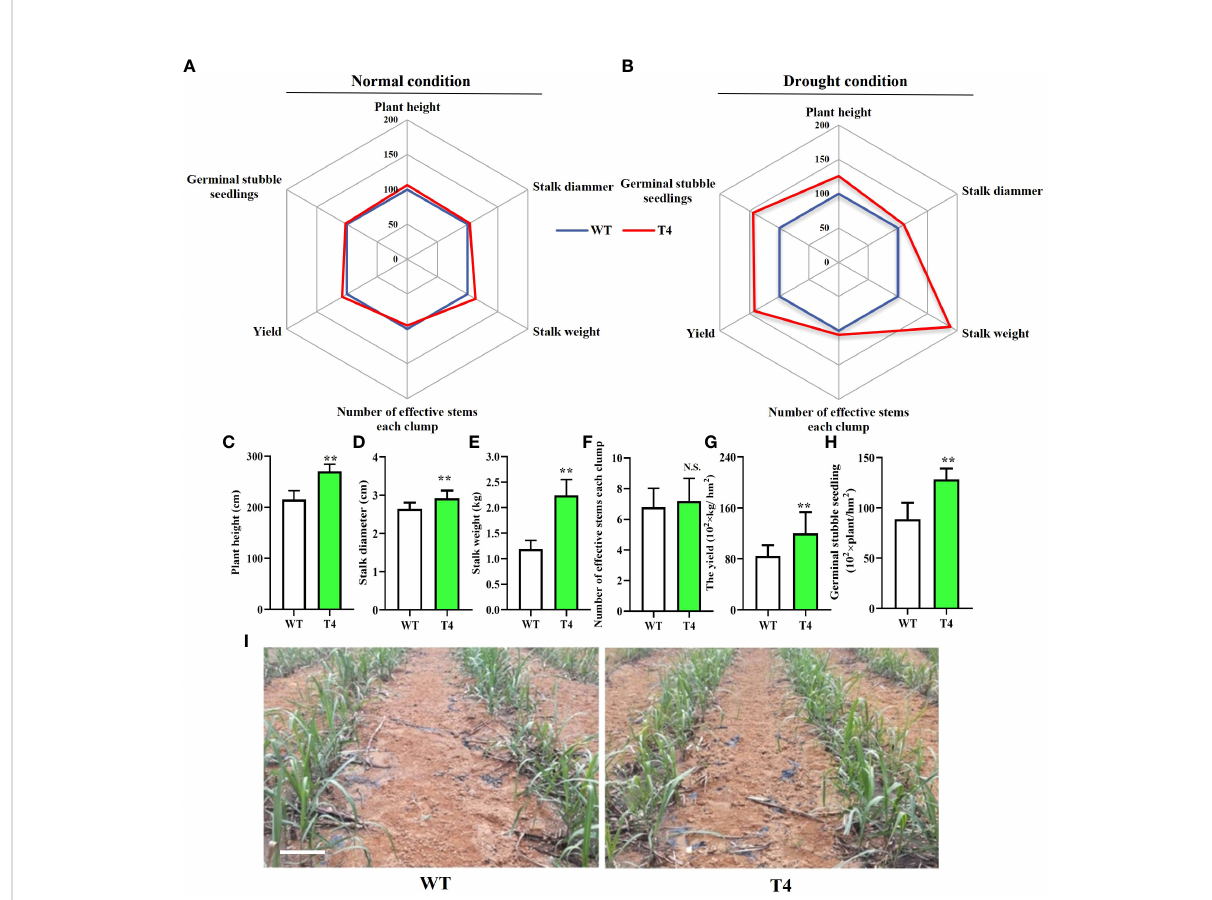
FIGURE 5 Agronomic traits of wild type (WT) and Prd29A:TaDREB2B transgenic (T4) sugarcane under the water-limited conditions in the fi eld. (A, B) Agronomic traits of Prd29A: TaDREB2B transgenic and WT plants grown in the fi eld under both normal (A) and drought (B) conditions. Mean values from WT were set at 100% as a reference. Each data point shows a percentage of the mean values. (C – H) The plant height (C) , stalk diammer (D) , stalk weight (E) , number of effective stems for each clump (F) , the yield (G) , and germinal stubble seedlings (H) of WT and Prd29A: TaDREB2B transgenic sugarcane under water de fi cit condition. The values are the means ± SD; n=60 plants in (C – E) , n=9 clumps in (F) , and n=3 in (G) . All statistical analyses were performed using Student ’ s t -test: NS, no signi fi cance; ** P < 0.01. (I) Performance of germinal stubble seedlings of WT and Prd29A: TaDREB2B transgenic sugarcane after harvest following spring. Bar=20